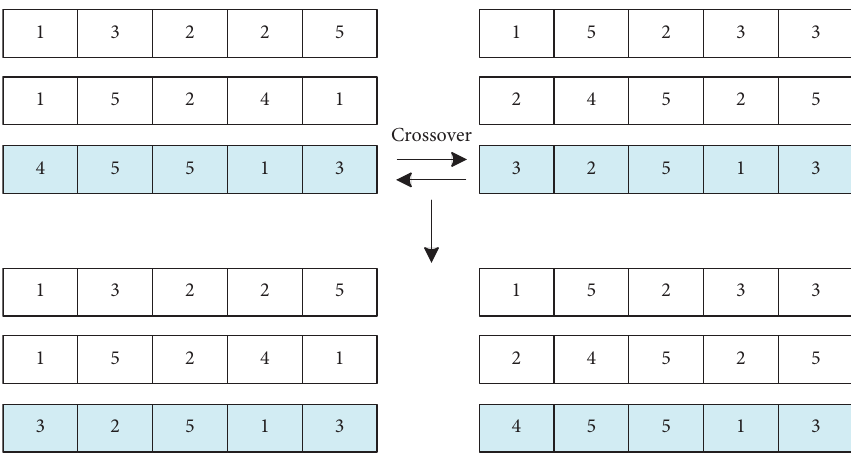
Figure 5: Crossover mechanism.